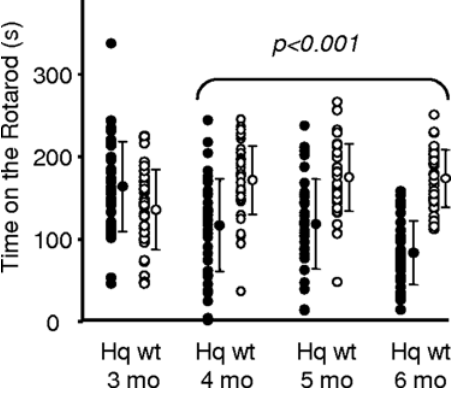
Figure 4. Variable Rotarod performance in control and Harlequin mice. Plots of individual results of three tests per animal (3 mo: 16 wild-type and 13 Hq mice; 4 mo: 11 wild-type and 13 Hq animals; and 5 and 6 mo: 15 wild-type and 11 Hq animals) showing the wide variability of values in both the Hq and control populations at each time point. The mean and standard deviation are shown for each distribution. Despite the major variability, t -tests showed significantly poorer performance in the Hq mice at 4 mo of age.